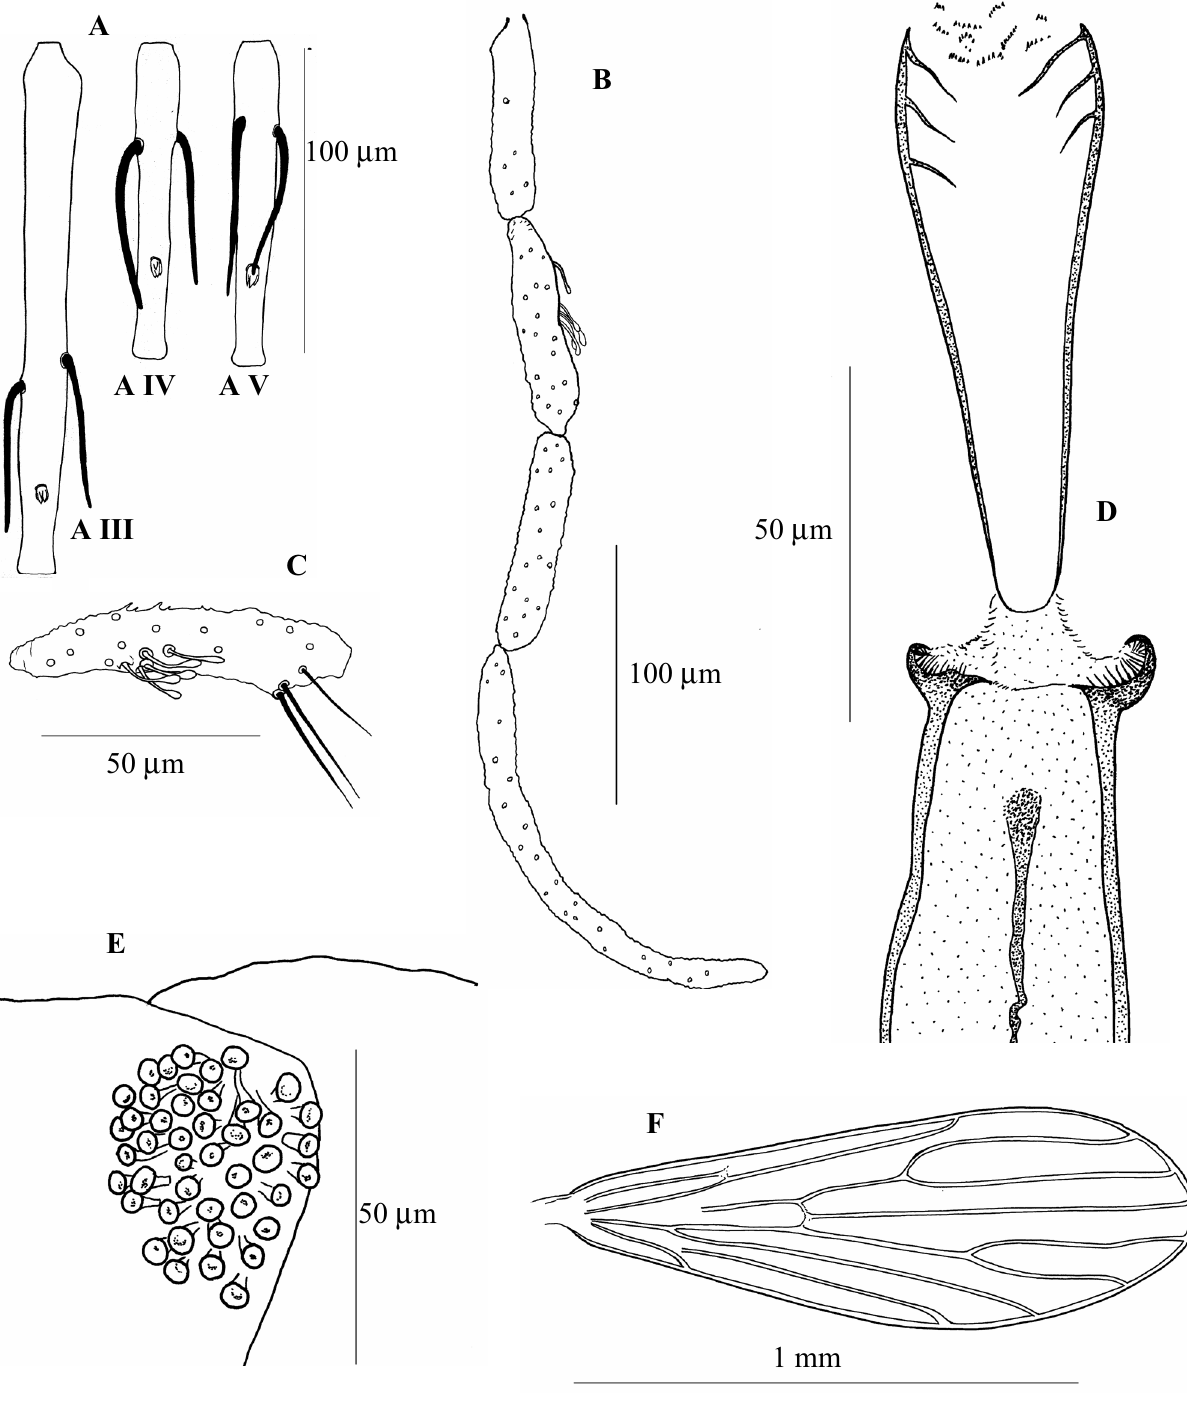
Fig. 2. – C. barbazani n. sp. mâle. A : segments antennaires III, IV et V; B : palpe; C : troisième segment palpal; D : pharynx et ciba- rium; E : glandes en trompettes sur le quatrième tergite; F :